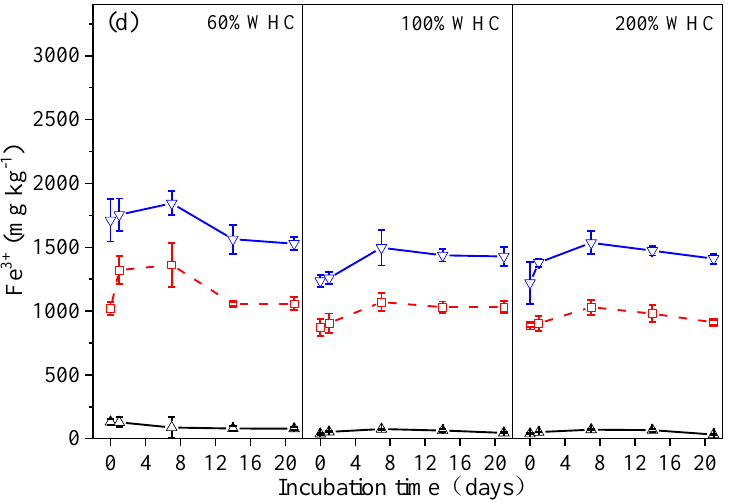
Figure 5. The concentrations of Fe 2+ and Fe 3+ during the incubation in hydromorphic ( a , c ) and gleyed ( b , d ) paddy soils with and without goethite addition. The values represent the mean of three replicates, and the error bars represent standard errors.